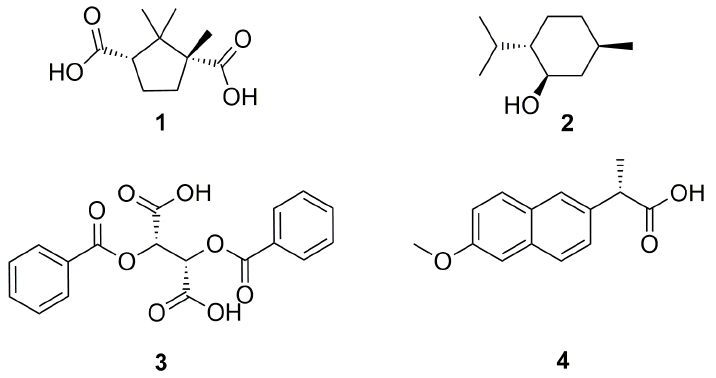
Figure 1. Enantiopure resolving agents as precursors of lipophilic enantioselector molecules used in liquid membranes.